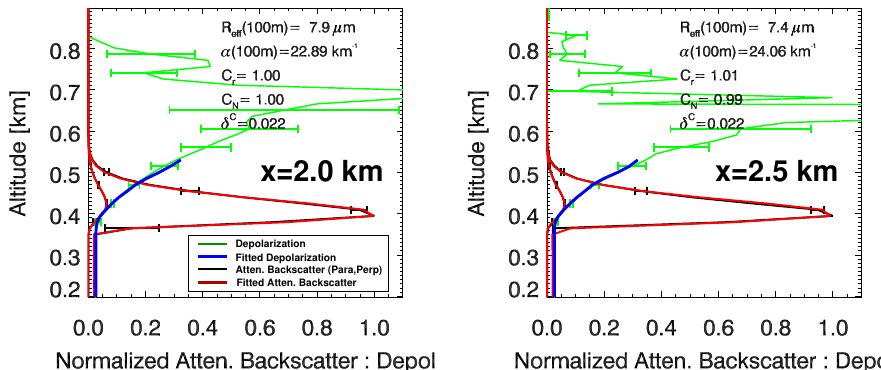
Figure 10. Results of the retrieval applied to the simulated lidar data along for two columns (corresponding to x = 2 . 0 and 2.5km). Here the black lines are the simulated observations at a vertical resolution of 15m and a horizontal resolution of 400m while the corresponding depolarisation ratio is given by the green line. Here C r was set to 1.0 and the depolarisation cross-talk parameter ( δ C ) was set to 0.3. The red lines are the fits to the parallel and perpendicular attenuated backscatter and the blue line is the corresponding fit depolarisation